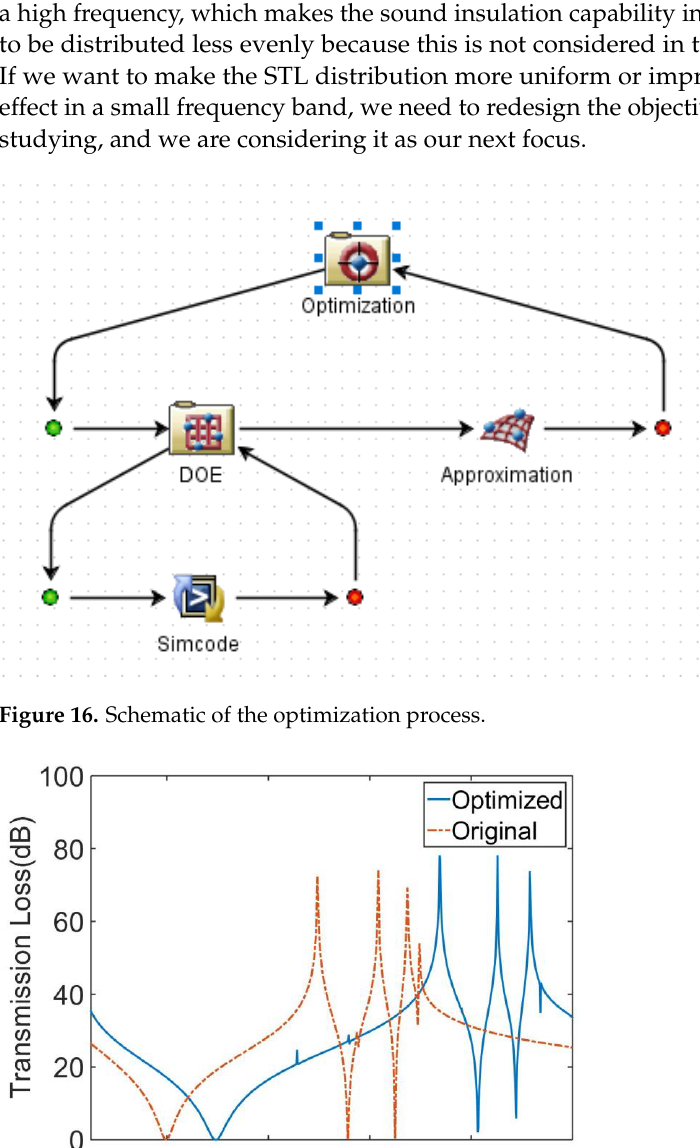
Table 2. Original and optimized design variable values.